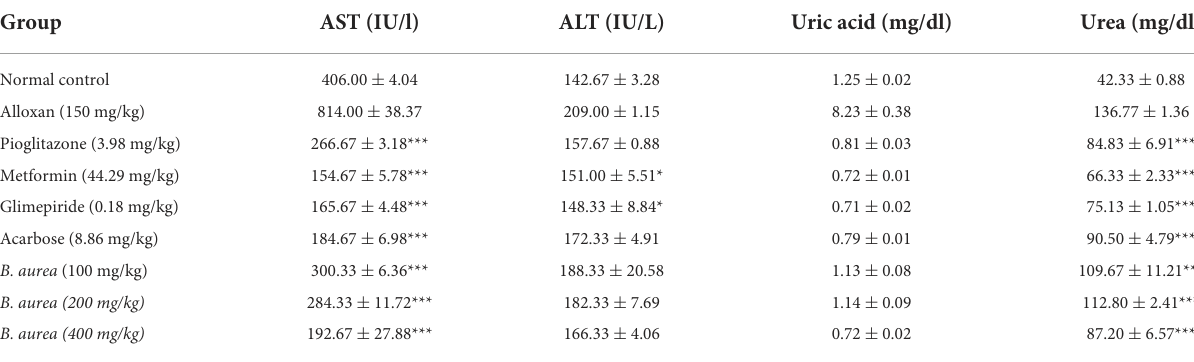
TABLE 3 Effect of B. aurea and standard treatments on LFT and RFT in diabetic rats. Group